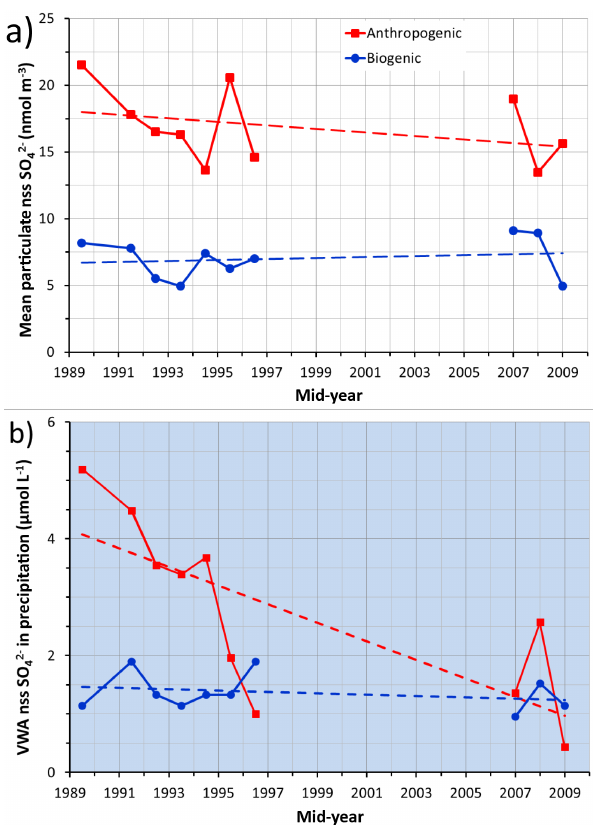
Figure 4. Temporal trends in anthropogenic and biogenic contri- butions to nss SO 2 − associated with (a) aerosols (white back- 4 grounds) and (b) precipitation (light-blue backgrounds) sampled under NEUS/SEUS